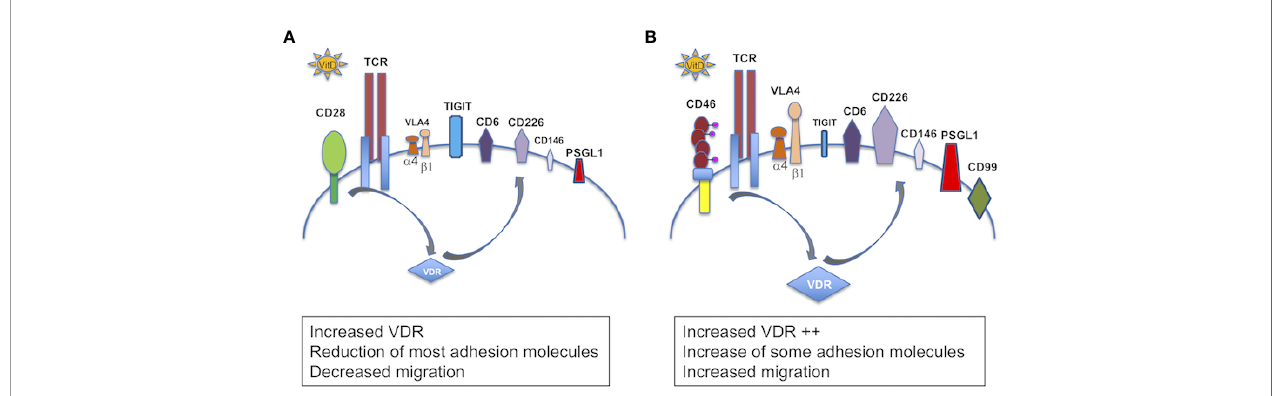
FIGURE 10 | Schema summarizing the role of vitamin D in the modulation of adhesion of T cells. Schema summarizing the effect of 1,25(OH)2D3 on the modulation of expression of adhesion molecules in (A) CD28- and (B) CD46-costimulated T cells. In the presence of 1,25(OH)2D3, CD28 costimulation increases VDR, decreases expression of VLA4 (CD49d and CD29) and CD146, and moderately induces CD6, CD226 and PSGL1, and promotes TIGIT expression. CD46 costimulation leads to a larger VDR expression, decreases CD49d but maintains CD29, strongly promotes expression of CD6, CD226, PSGL1, and induces CD99. CD46 costimulation also decreases expression of CD146 and represses